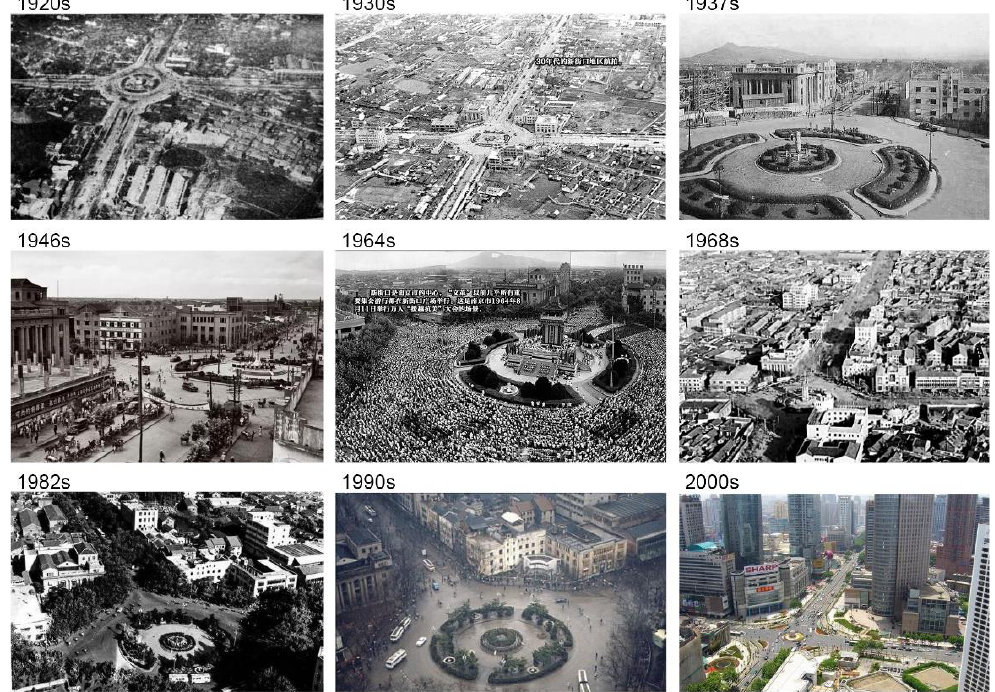
Figure 2. The spatial structure of Xinjiekou evolved and the public participation of the residents. In the 1920s–1946 it was mainly as a square for walking through, in 1964–1990s the public participation opportunities of the residents increased, and the participation mode was mainly political activities and leisure activities. In the 2000s onwards, motor vehicles occupied the main position and the public participation capacity decreased. (History photos from http://dfz.nanjing.gov.cn/, accessed on 18 April